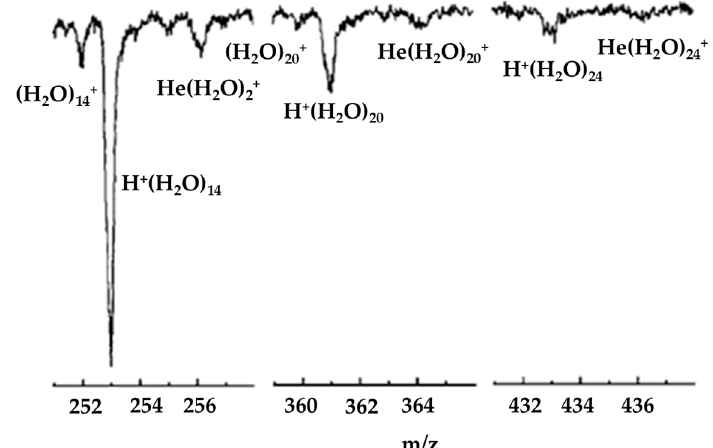
Figure 17. The n = 14, 20 and 24 regions of a mass spectrum recorded from water clusters (H 2 O) n in helium nanodroplets. Figure adapted from [55] with permission. Copyright 2007 American Institute of Physics.